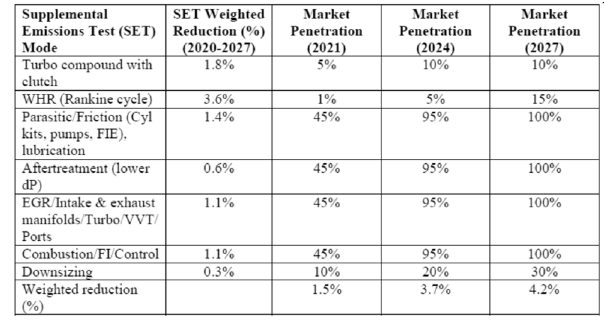
Fig. 5. Projected large truck engine fuel consumption reductions (relative to 2017 engines)